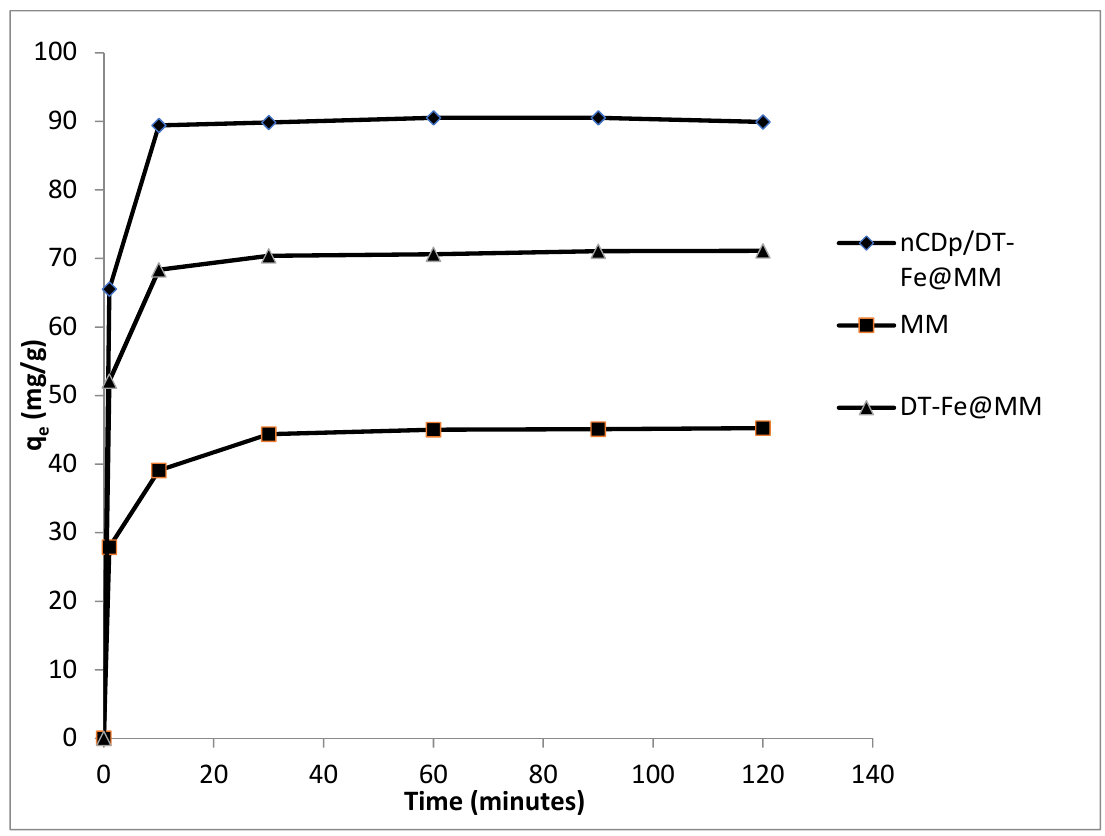
Figure 11. Effect of adsorption time on the removal of BPA. (Adsorption conditions: C o 50 mg/L; T = 30 °C; dosage = 0.02 g/L; pH = 7).